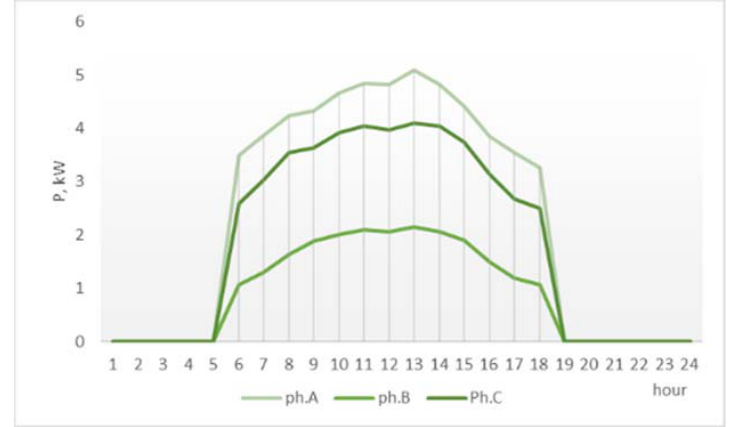
Figure 14. Generation in network R121.